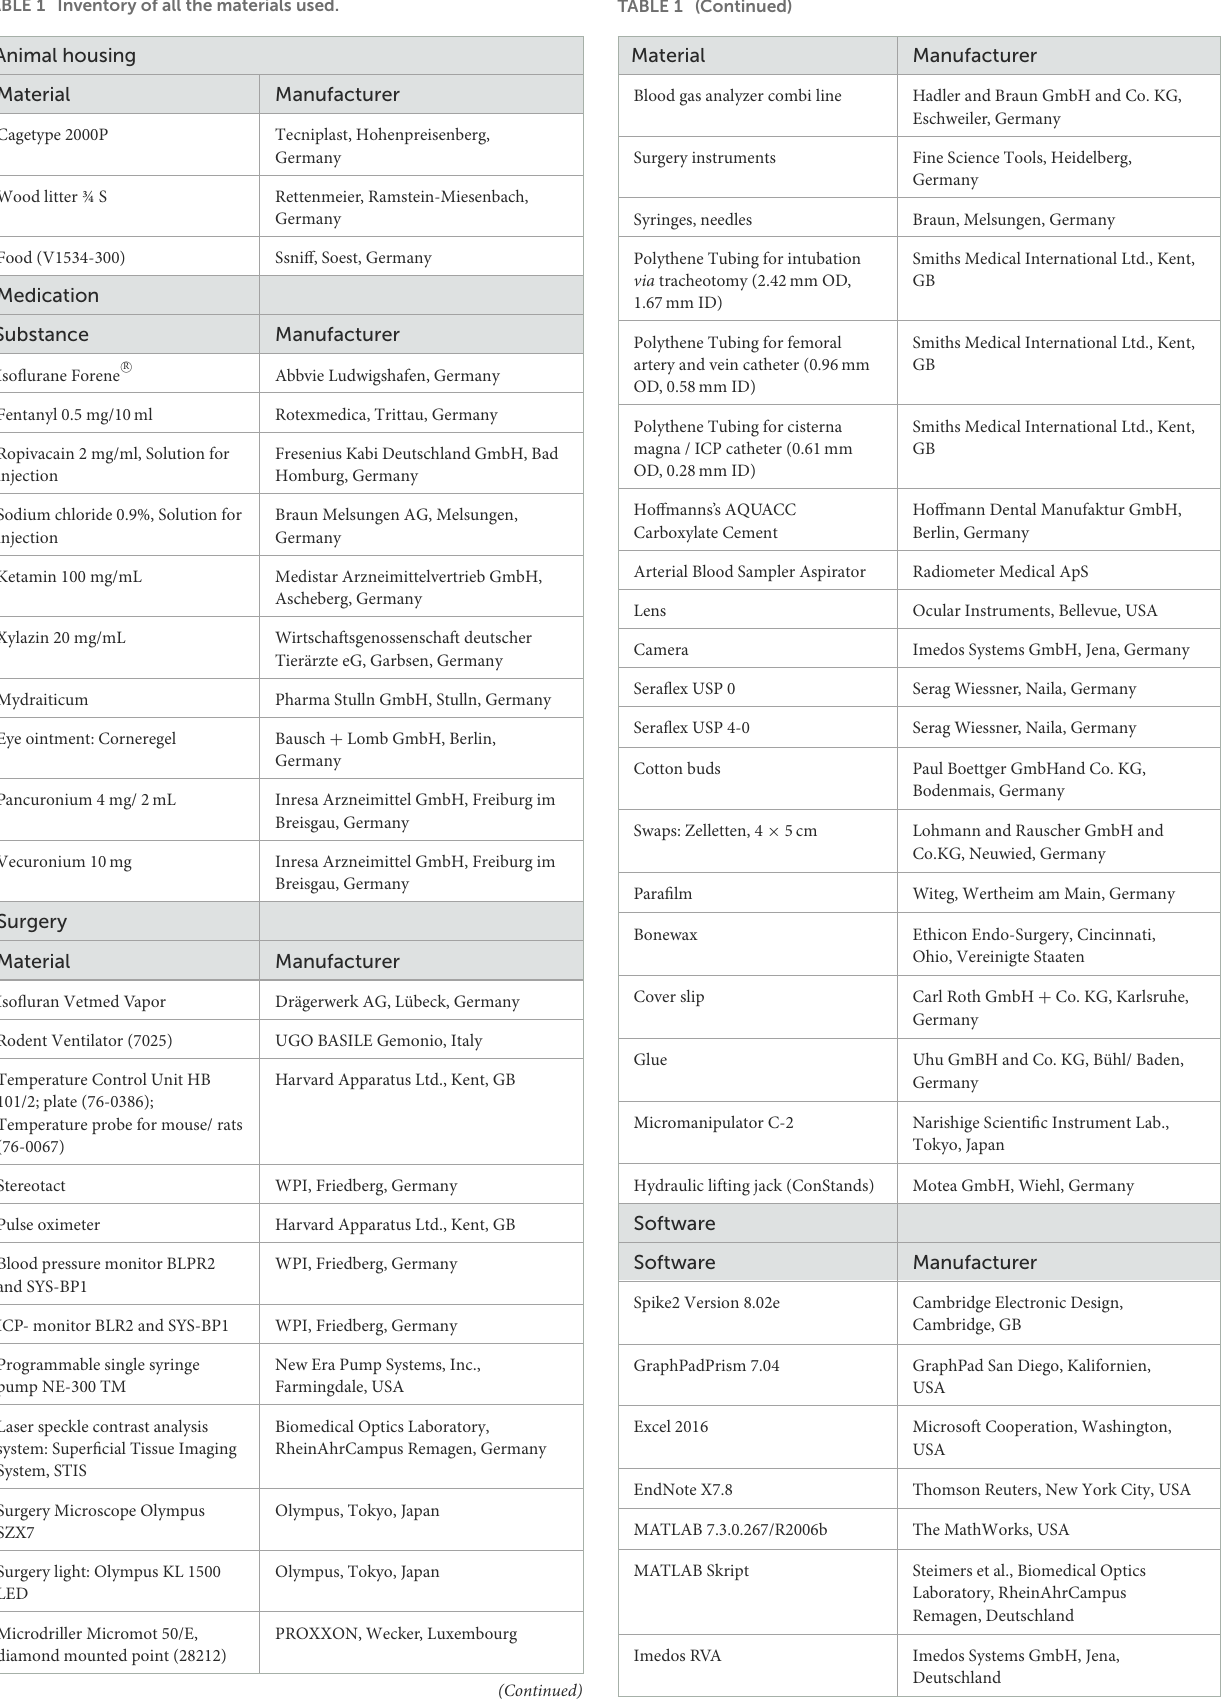
TABLE 1 Inventory of all the materials